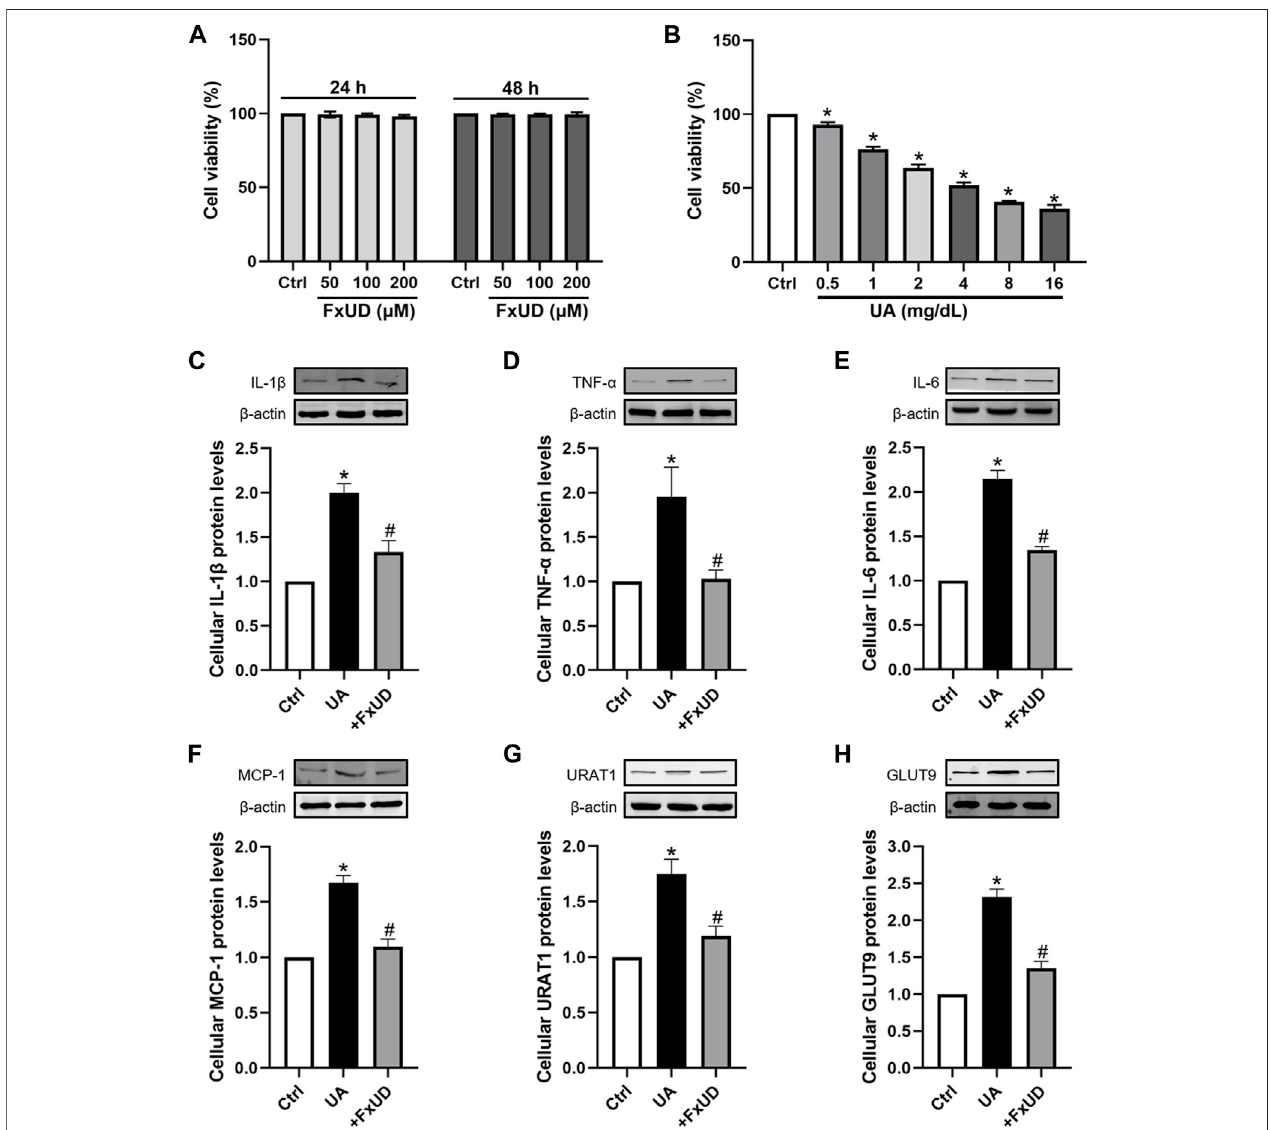
FIGURE 8 | FxUD regulates the expression of in fl ammatory cytokines and uric acid reabsorption transporters in uric acid-exposed HK-2 cells. (A) Changes in the viabilityofHK-2 cells following 24or 48 h oftreatment withchemicals at different concentrations,measuredusing CCK-8assay ( n (cid:1) 3). (B) Cell viability after treated with variousconcentrationsofUA for24 h, and thefollowingstudies wereperformed( n (cid:1) 4). (C – H) RepresentativeWestern blot bandsand protein levels ofIL-1 β ,TNF- α ,IL- 6, MCP-1, URAT1 and GLUT9 in HK-2 cells, respectively ( n (cid:1) 4). Values are expressed as the means ± SD. * p < 0.05 vs. Ctrl, # p < 0.05 vs. UA. UA, uric acid.